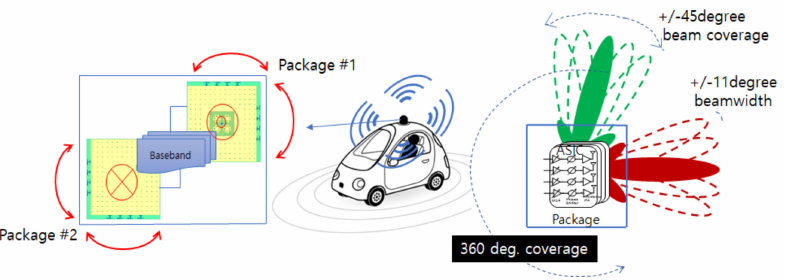
Figure 3. End-fired package structure that covers 360 degrees with two packages.